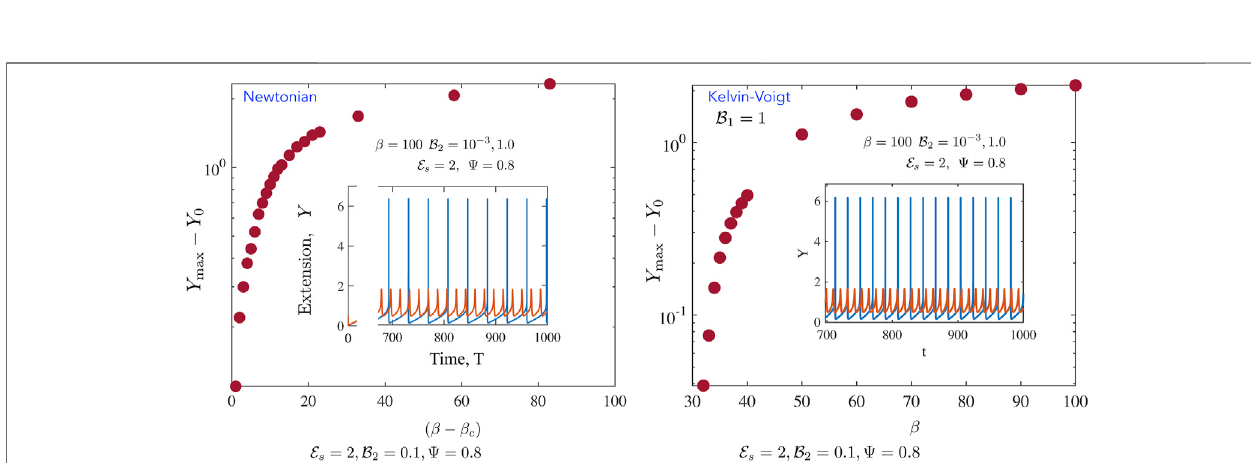
FIGURE6| Representativemetricsforthefullynon-linearperiodicsolutionsforthe(left)Newtonian,and(right)Kelvin-Voigtcases(Newtonian,left)Wecalculatethe maximum value of Y max over a cycle and plot Y max − 1 as a function of β − β c where the critical value of beta for these parameters ( E s (cid:2) 2 , B 1 (cid:2) 0 . 1 , Ψ (cid:2) 0 . 8 ) is β c ≈ 18.9. That the bifurcating solutions arise via a supercritical Hopf-Poincare-Andronov bifurcation is deduced by the amplitude going to zero at criticality. For large deviations from the critical value of β . the amplitude decreases slowly. The inset shows sample steady periodic solutions at β =100 ≫ 18.9 (far from the critical point) for B (cid:2) 10 − 3 (blue) and 1.0 (red). We note that as one goes far from the critical point, oscillations become highly asymmetric and the maximum value of Y attained deviates 2 signi fi cantly from the minimum value. (Kelvin-Voigt, right) Here we plot Y max − 1 as a function of β . Note that the amplitude of the oscillation tends to zero as one approachesthecritical point. Comparison withtheNewtonian case indicates aslowerincrease intheamplitude,aswellasalowermagnitudeoftheamplitudes forlarge β . Examination of the time-series indicates that the frequencies (inset) are substantially higher than for the Newtonian case with the same value of B